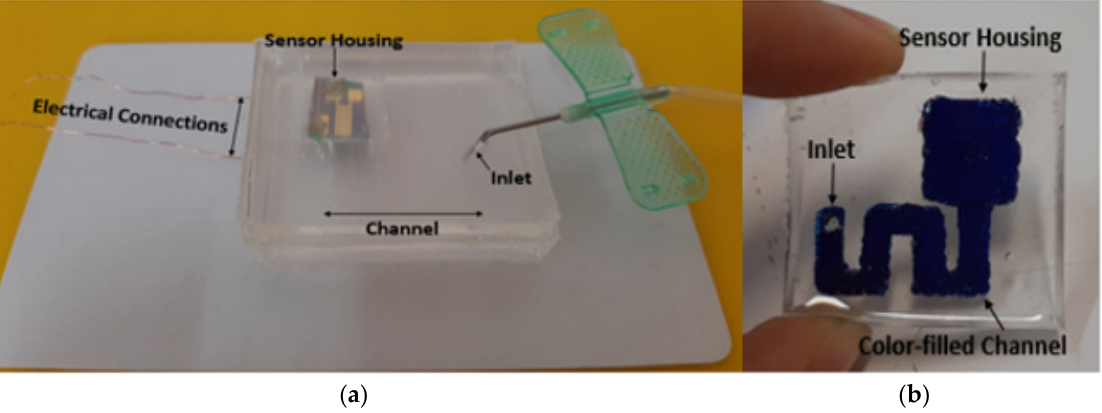
Figure 2. ( a ) The fabricated microfluidic-based gas-sensing system. ( b ) Colored channel of gas-sens- ing system for clarification. sensing system for